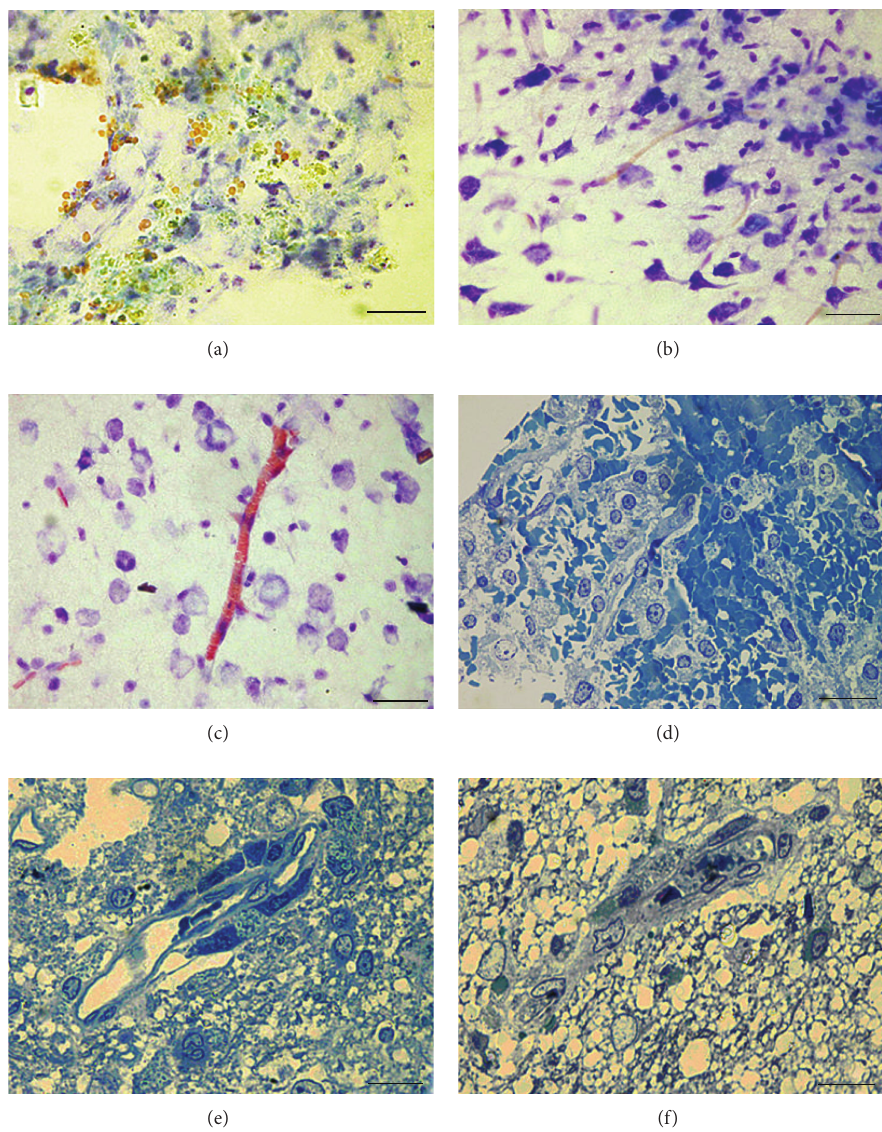
Figure 5: Morphological characteristics of group 3. (a) Group 3: infiltrate zone. Extravascular arrangement of numerous erythrocytes and many macrophages containing green granules. (b) Group 3. boundary zone. Blood stagnation in capillary tubes. (c) Group 3: normal cortex, according to the structure of neurons, surrounding a damaged zone. Noticeably widened capillary tube with erythrocytes accumulated inside and pressed into rouleaux formation. (d) Group 3: extravasate. Macrophages containing pale granules. Semi-thin section. (e) Group 3: blood vessel in the infiltration zone. A circle of macrophages with green granules surrounds the vessel. Semi-thin section. (f) Group 3: blood vessel in the infiltration zone (more destroyed than (e)); a sphere of dark macrophages surrounds the vessel. Semi-thin section. The scale bars in (a)–(f) are 20 𝜇